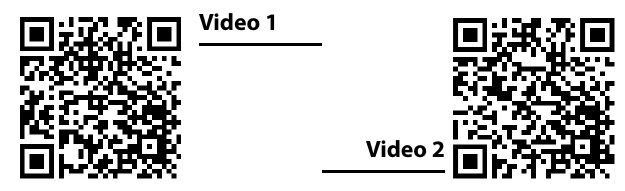
(Table 2, Figure 4). The left and right radial groups were compared in terms of primary endpoints. Left radial access was found to be significantly better in terms of total procedure time (17.68±2.34 min vs .